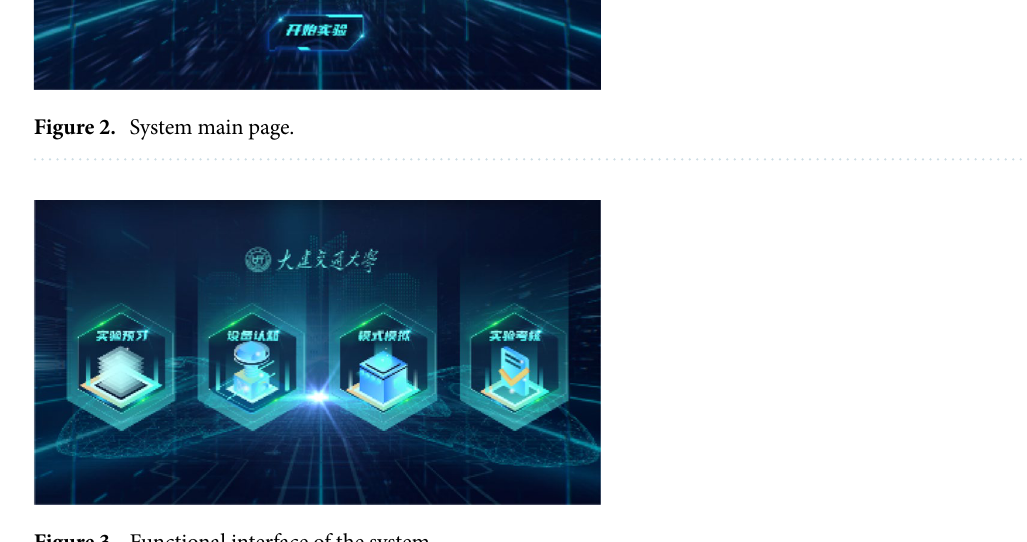
Figure 3. Functional interface of the